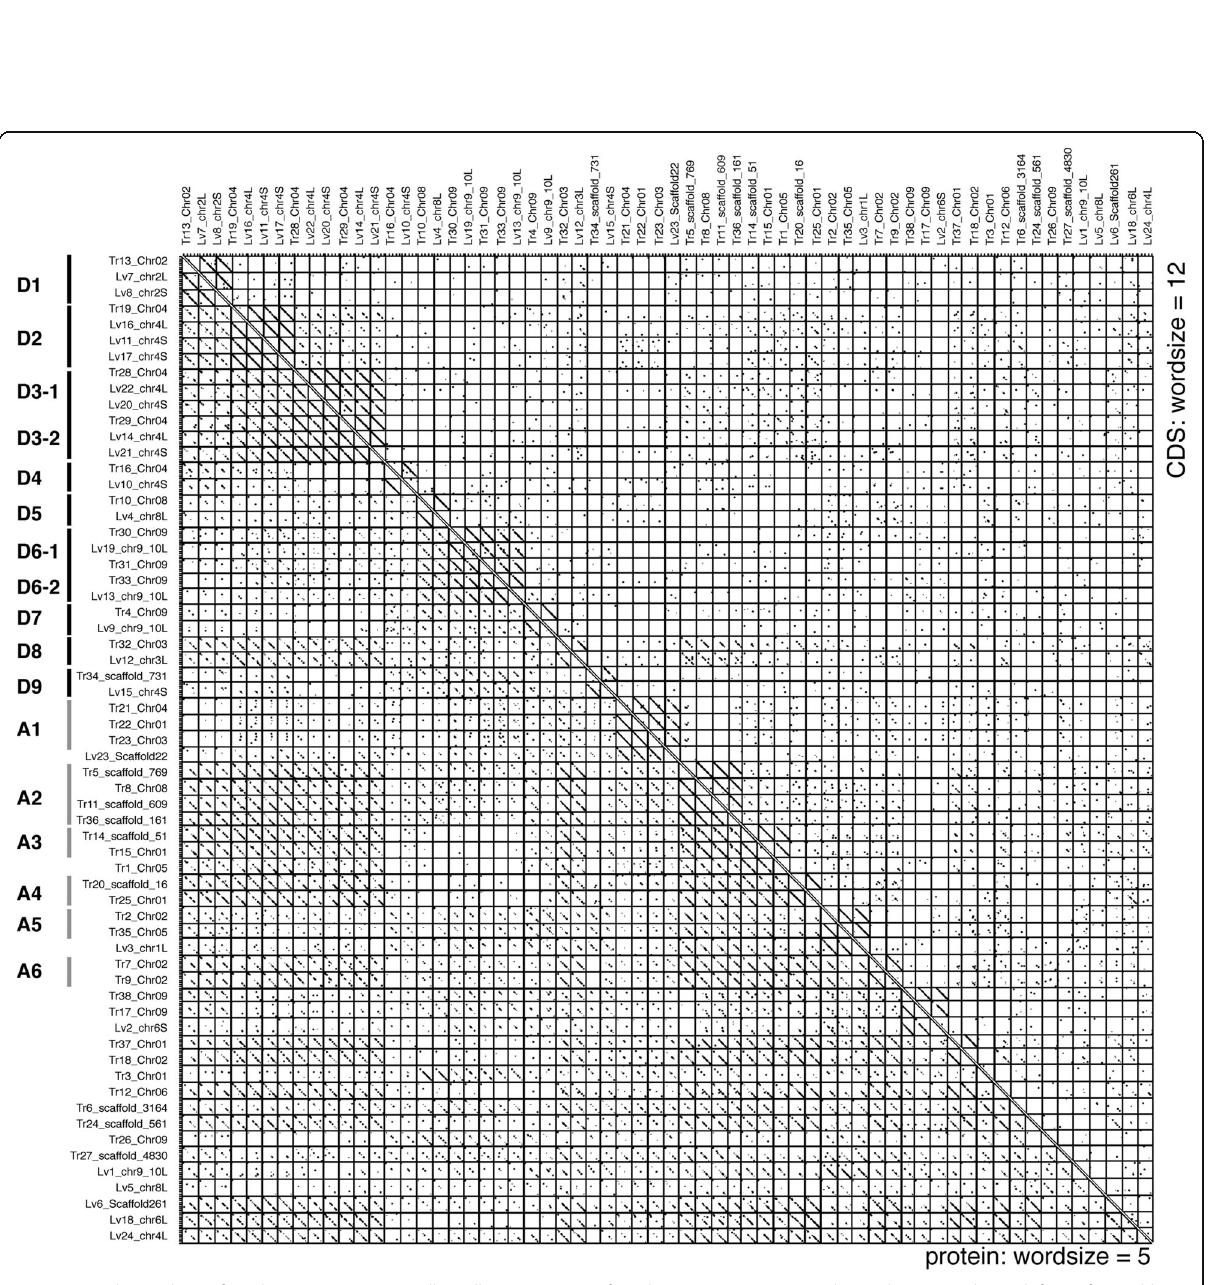
Fig. 3 Dot plot analysis of XKol -Tpase gene CDSs. All-to-all comparisons of XKol -Tpase CDSs (upper right) and proteins (lower left) performed by dot plot analyses. D1 – D9 and A1 – A6 are grouped in the same way as in Fig.